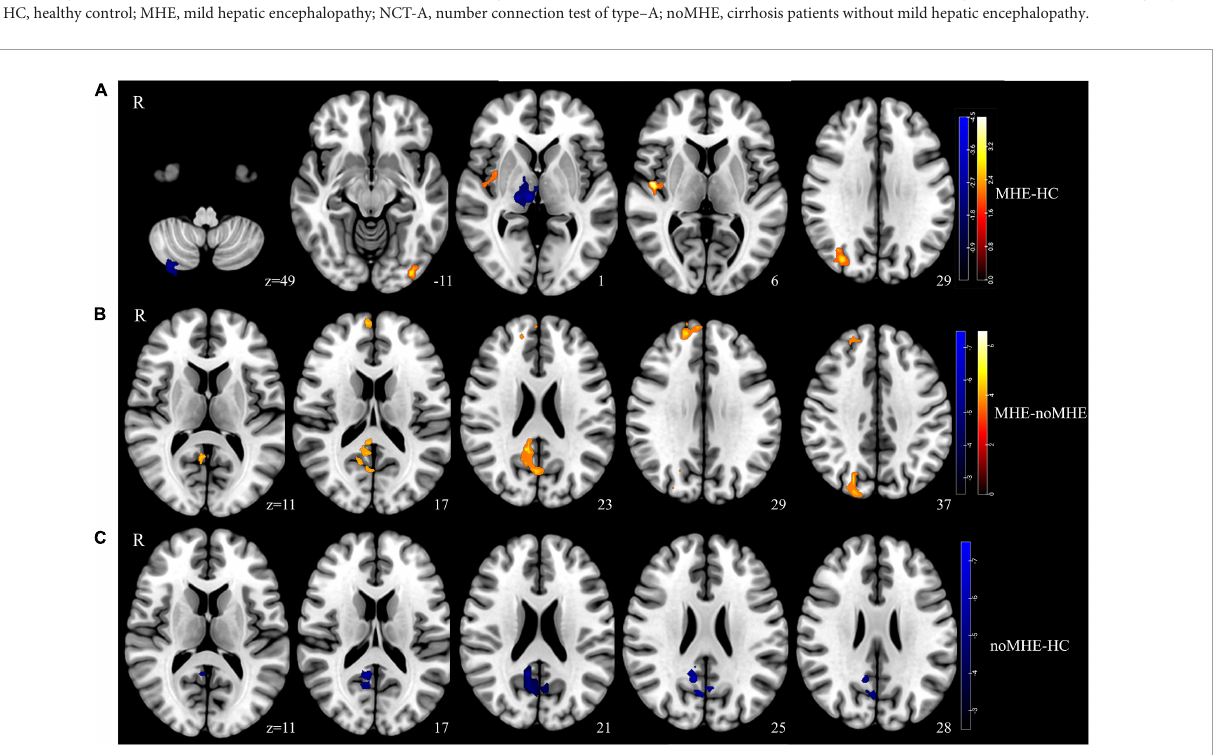
Data are presented as the mean ± standard deviation. † Pearson χ 2 test of two groups (two-tailed). ‡ One-way analysis of variance test among three groups. § Two-sample t -test between the MHEandHCgroups(two-tailed). || Two-sample t -testbetweennoMHEandHCgroups(two-tailed). ¶ Two-sample t -testbetweentheMHEandnoMHEgroups(two-tailed).DST,digit-symbol